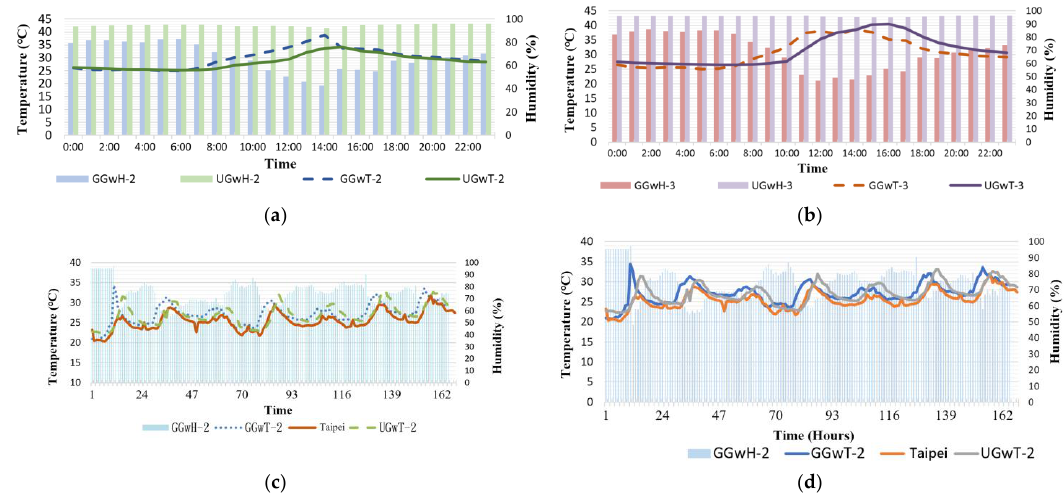
Figure 6. Temperature and humidity of permeable brick pavement ( a ) Region C, ( b ) Region D, ( c ) temperature reduction effect in Region C, and ( d ) temperature reduction effect in Region D. Table 10. Regions C and D: Similarities between permeable brick pavements.